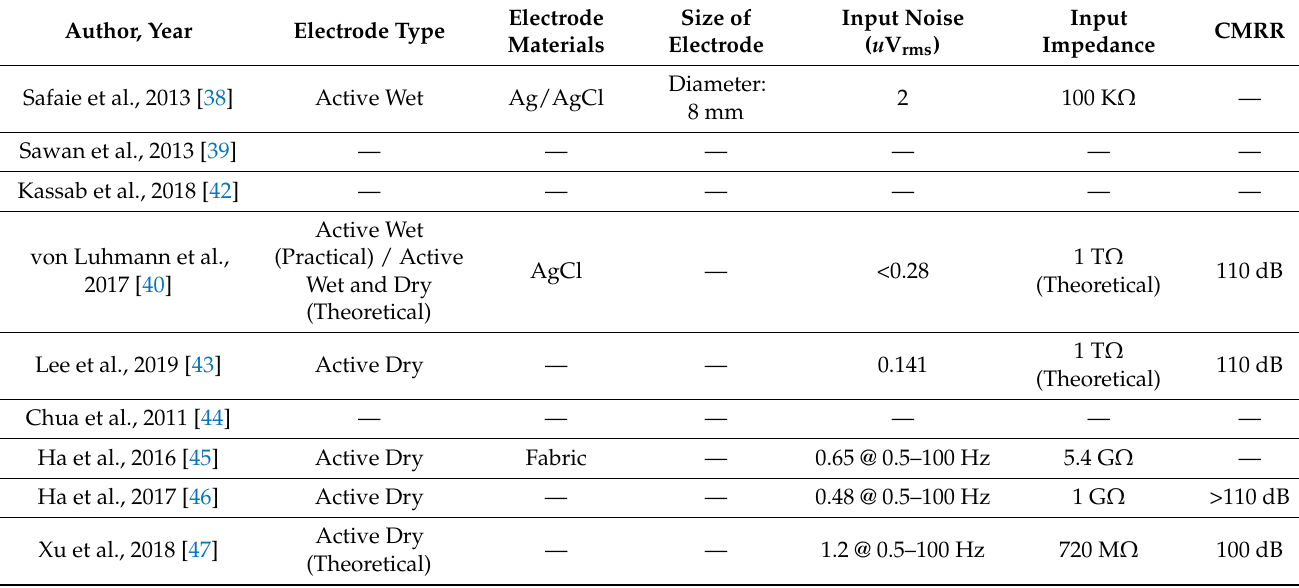
Table 3. Characteristics of EEG electrodes and front-end amplifiers used in key wearable, integrated EEG–fNIRS technologies. Note: the use of the em dash (—) symbol indicates that the information is not